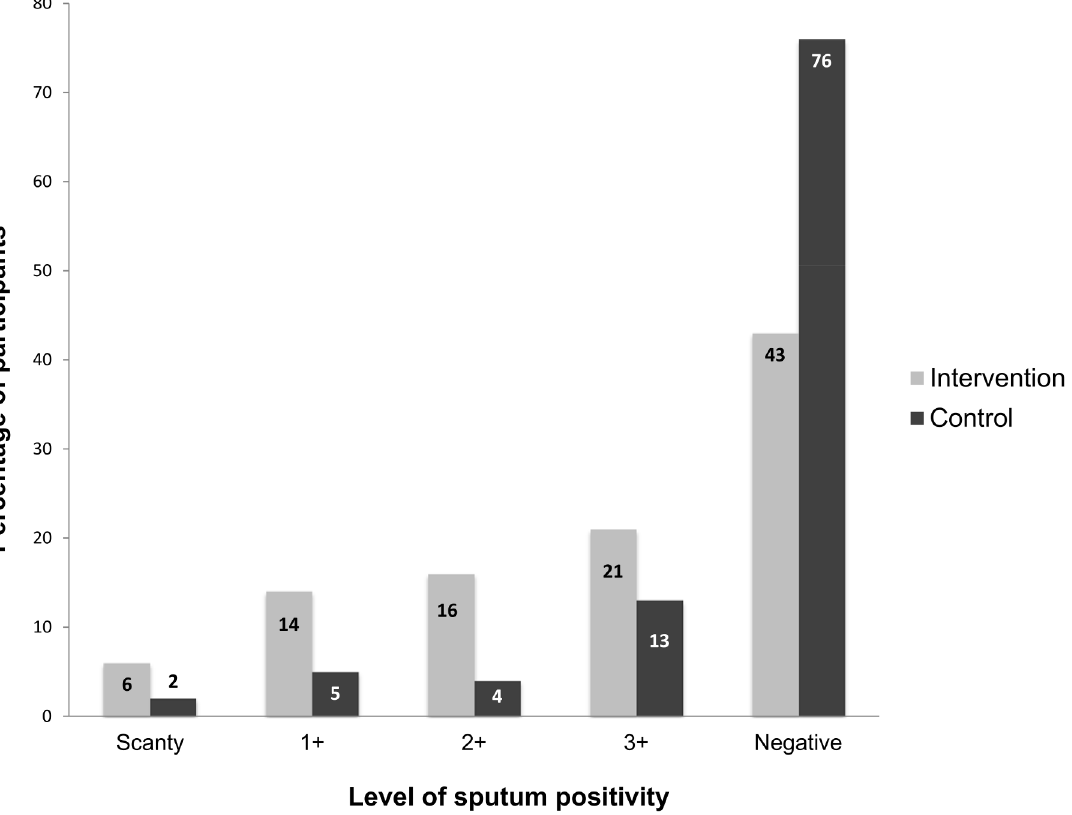
Fig 4. Quantitative grading scale of sputum smear microscopy results in the intervention (exposure to the sputum submission instruction video) and control group (standard of care). Numbers on the bars indicate absolute number of patients. Overall P value across groups was < 0.0001.